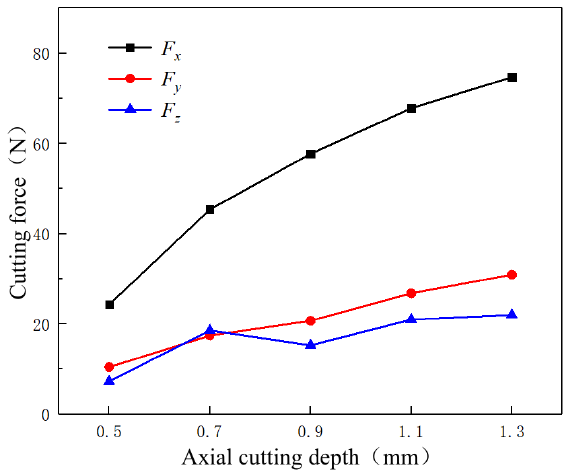
Figure 12. Variation trend of cutting force at different axial cutting depths.